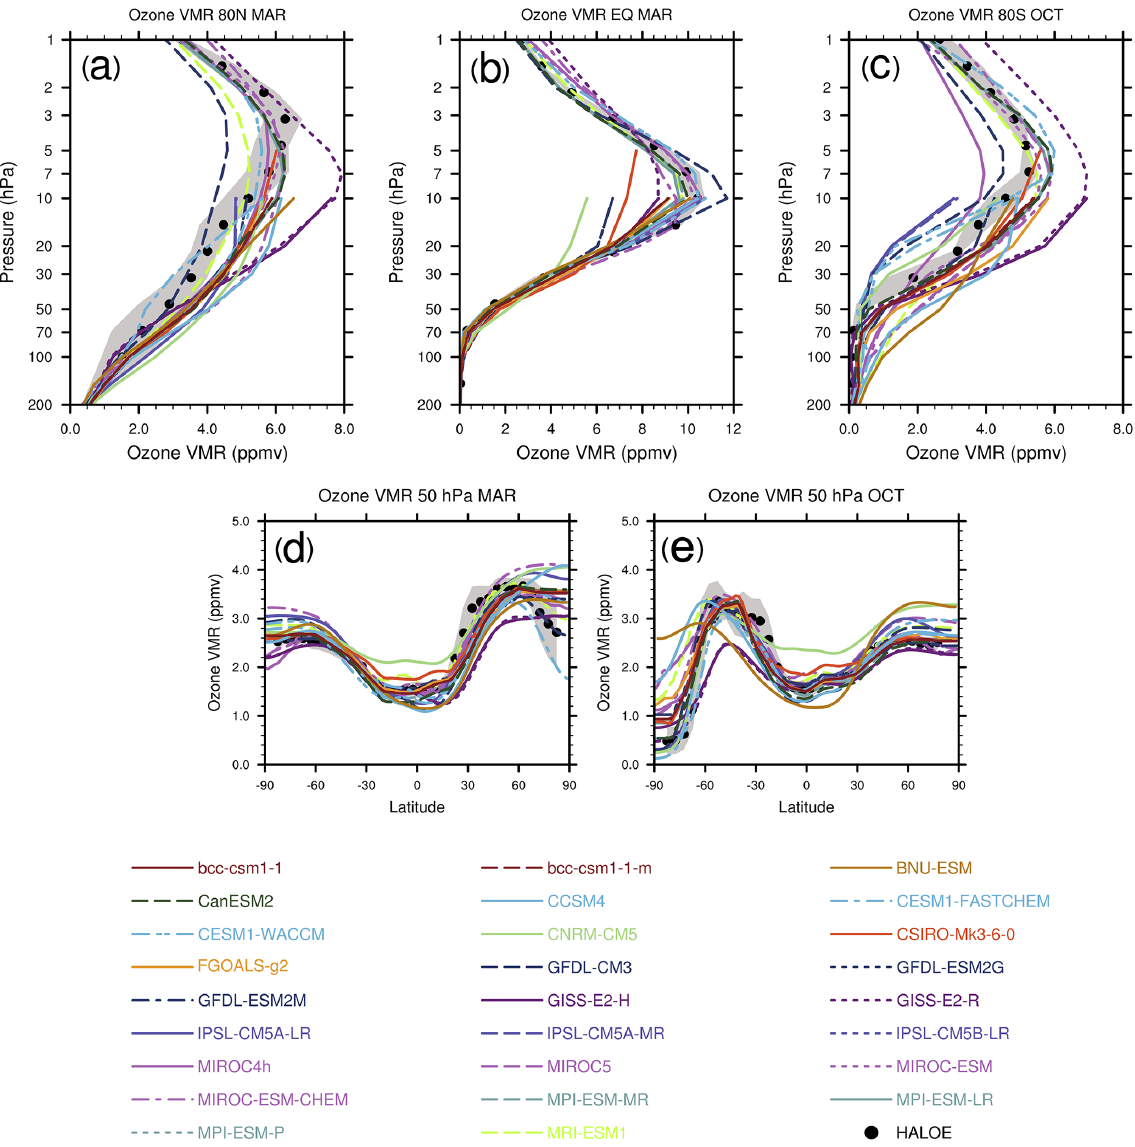
Figure 43. Climatological zonal mean ozone mixing ratios from the CMIP5 simulations and HALOE in parts per million by volume. Vertical profiles at (a) 80 ◦ N in March, (b) 0 in March, and (c) 80 ◦ S in October. Latitudinal profiles at 50hPa in (d) March and (e) October. The grey area shows HALOE plus and minus 1 standard deviation ( s ) about the climatological zonal mean. Similar to Fig. 5 of Eyring et al. (2006) and produced with the recipe_eyring06jgr.yml . See details in Sect.